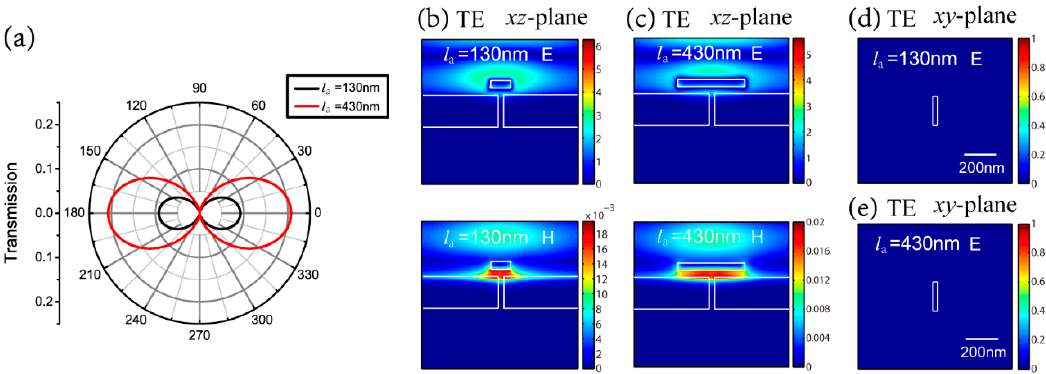
Figure 3. ( a ) Transmission with di ff erent polarization angles at l a = 130 nm and l a = 430 nm; electric and magnetic field distributions of ( b ) l a = 130 nm and ( c ) l a = 430 nm for transverse electric (TE) polarization in the xz section; electric field distributions of ( d ) l a = 130 nm and ( e ) l a = 430 nm for TE polarization at the aperture export.